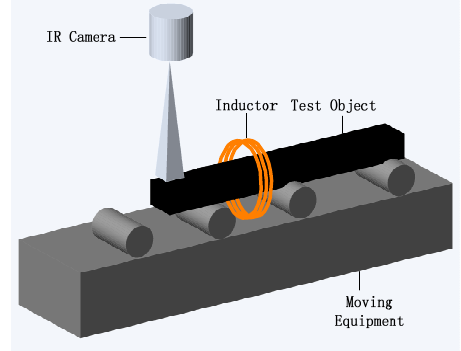
Figure 5. Experimental setup with the inductor controlled by moving equipment.